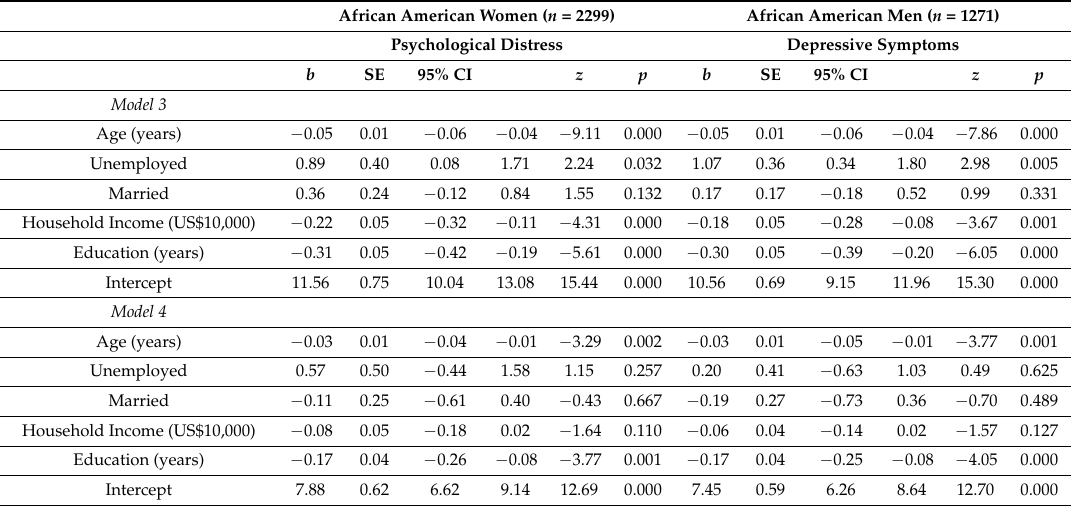
Table 3. Summary of linear regression on the effects of education attainment on depressive symptoms and psychological distress in African American adults by